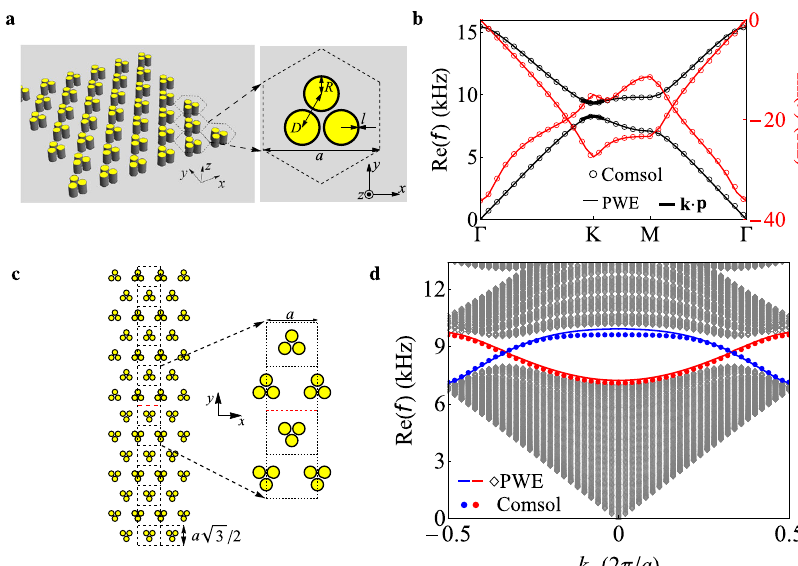
Fig. 1 Band structure of the non-Hermitian sonic kagome lattice. a Illustration of the non-Hermitian lattice under investigation, including a magni fi cation of the unit cell whose rigid cylinders are coated by a complex fl uid-layer of thickness l = 0.1 R to emulate the activated CNT fi lm. b With a non-Hermiticity factor β = 0.05 of the complex mass density, the real (imaginary) dispersion bands are shown on the left (right) axis as obtained through the PWE method, fi nite element simulations (COMSOL) and a k ⋅ p method (only around the K-point). c Schematic of the ffiffiffi p 3 sonic valley-Hall zig-zag interface (red dashed line) whose supercell of size a ´ 7 a is highlighted by the black dashed line. The inset provides a clearer view of the rigid cylinders involved in the rectangular supercell structure. d Real valley-edge dispersion for the non-Hermitian supercell shown in c . The gray diamonds and the colored (red and blue) solid lines represent the bulk and the valley-projected edge states, respectively, using the PWE method. The corresponding colored dots represent the edge sates obtained by Finite-element